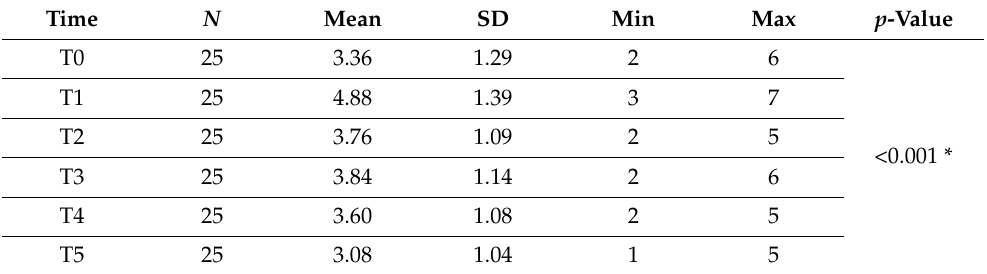
Table 4. Comparison of mean VAS scores between time intervals in the control group using Fried- man’s